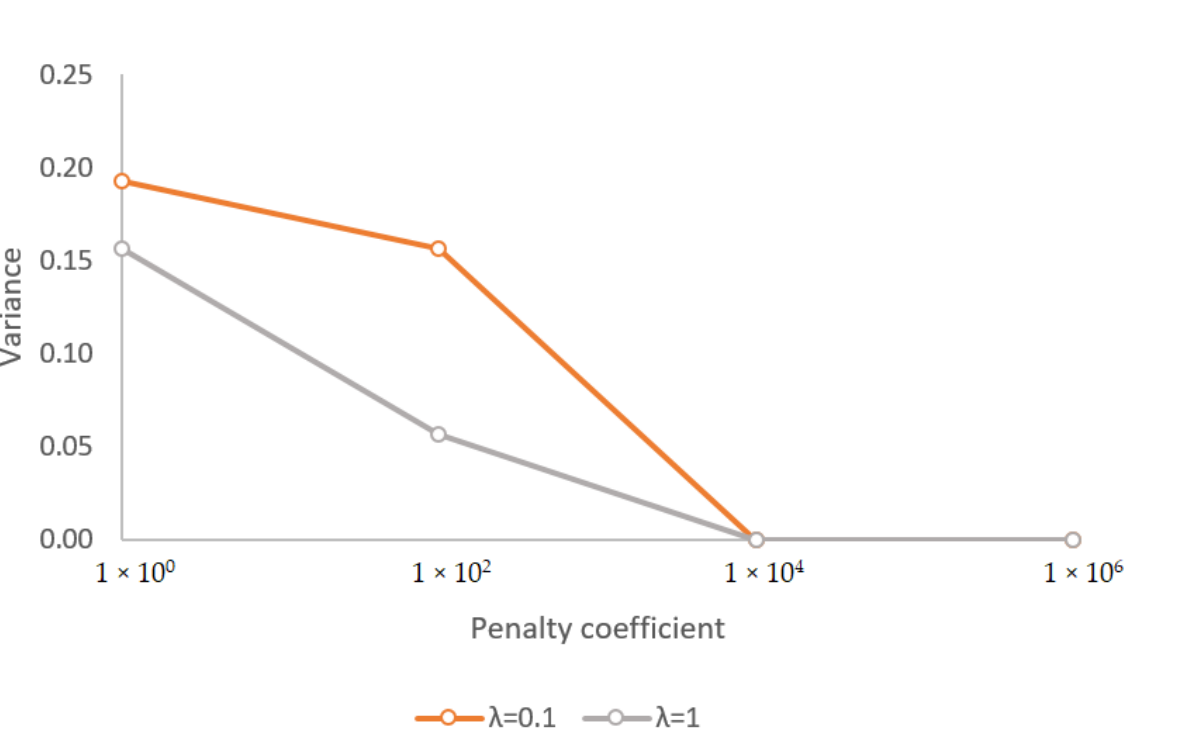
Figure 7. Variance between the performance of the solutions under different historic scenarios (i.e., the undelivered demand), for different values of the variance-factor ( λ = 0.1 in orange and λ = 1 in grey) and penalty coefficients ( Cpen ). The variance between the undelivered demand under different scenarios decreases with the penalty coefficient and is kept lower fora higher variance. A higher variance-factor increases the robustness of solutions. Table 7. Summary of the results obtained for the different optimization problems considering the future demand scenarios. OP